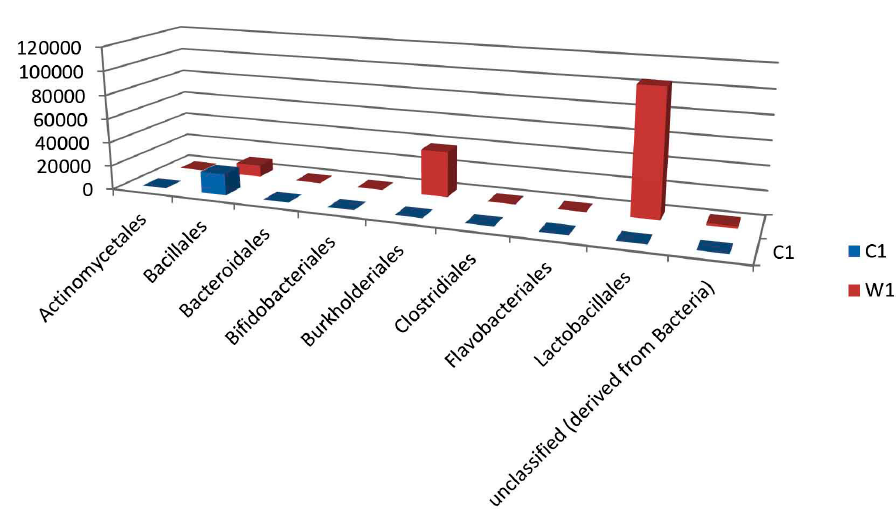
Fig. 6. Bar plot of Order level distribution